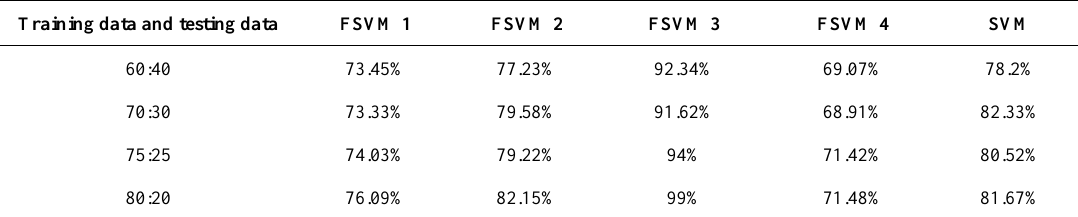
Table 3. Evaluation of Model Performance with Different Training and Testing Data Partitions Training data and testing